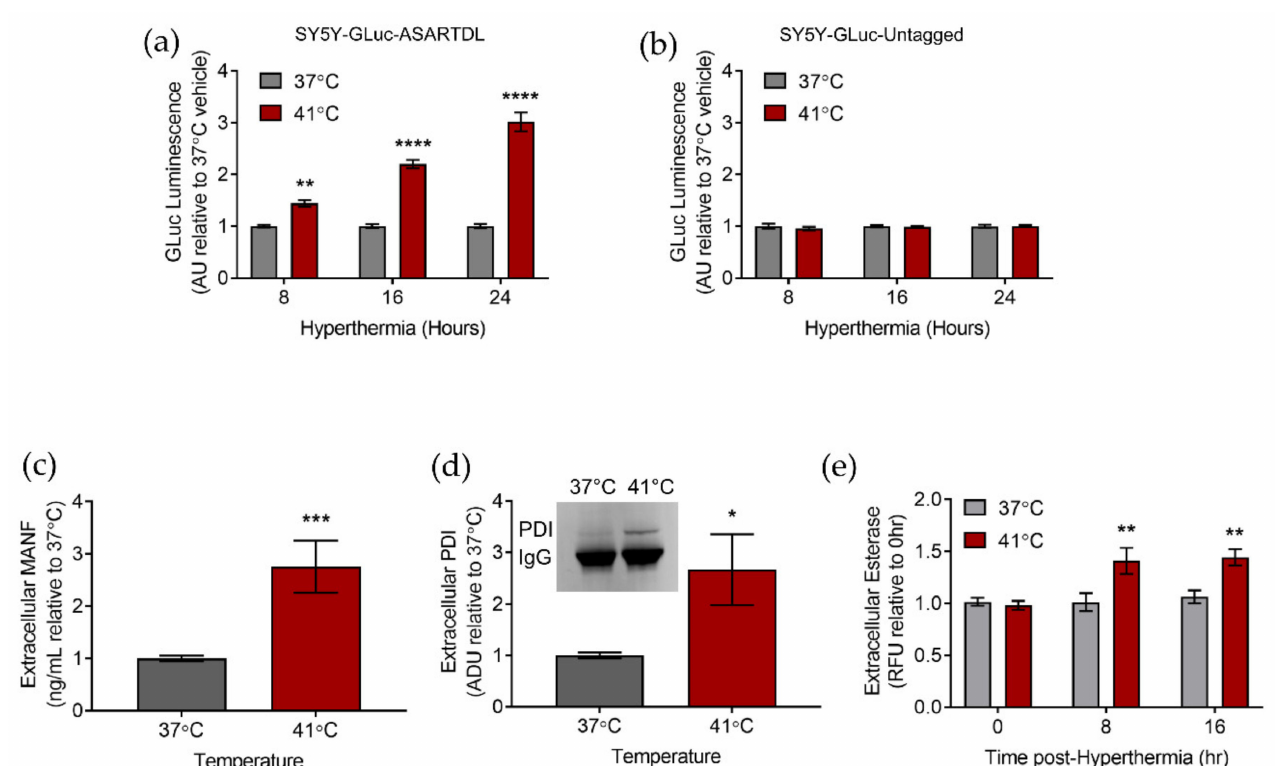
Figure 1. ER-resident protein secretion is triggered by hyperthermia. ( a , b ) GLuc (arbitrary units: AU) in the media from SH-SY5Y cells stably expressing ( a ) GLuc-ASARTDL or ( b ) GLuc-Untagged after an 8 h, 16 h, or 24 h incubation at 37 ◦ C or 41 ◦ C (mean ± SEM, n = 16, two-way ANOVA with Sidak’s multiple comparisons, ** p < 0.01 and **** p < 0.0001 37 ◦ C vs. 41 ◦ C). ( c ) Fold change in extracellular MANF from SH-SY5Y cells following a 24 h incubation at 37 ◦ C or 41 ◦ C (mean ± SEM, n = 5, t -test, *** p < 0.001). ( d ) Fold change in arbitrary density units (ADU) of immunoprecipitated PDI (representative blot shown) from media of SH-SY5Y cells following incubation at 37 ◦ C or 41 ◦ C (mean ± SEM, n = 3, t -test, * p < 0.05). ( e ) SH-SY5Y cells were exposed to 37 ◦ C or 41 ◦ C for 8 h or 16 h. Fluorescent esterase assay of cell culture media presented as a fold change in raw fluorescent units (RFU) (mean ± SEM, n = 12, two-way ANOVA with Sidak’s multiple comparisons, ** p < 0.01 37 ◦ C vs. 41 ◦